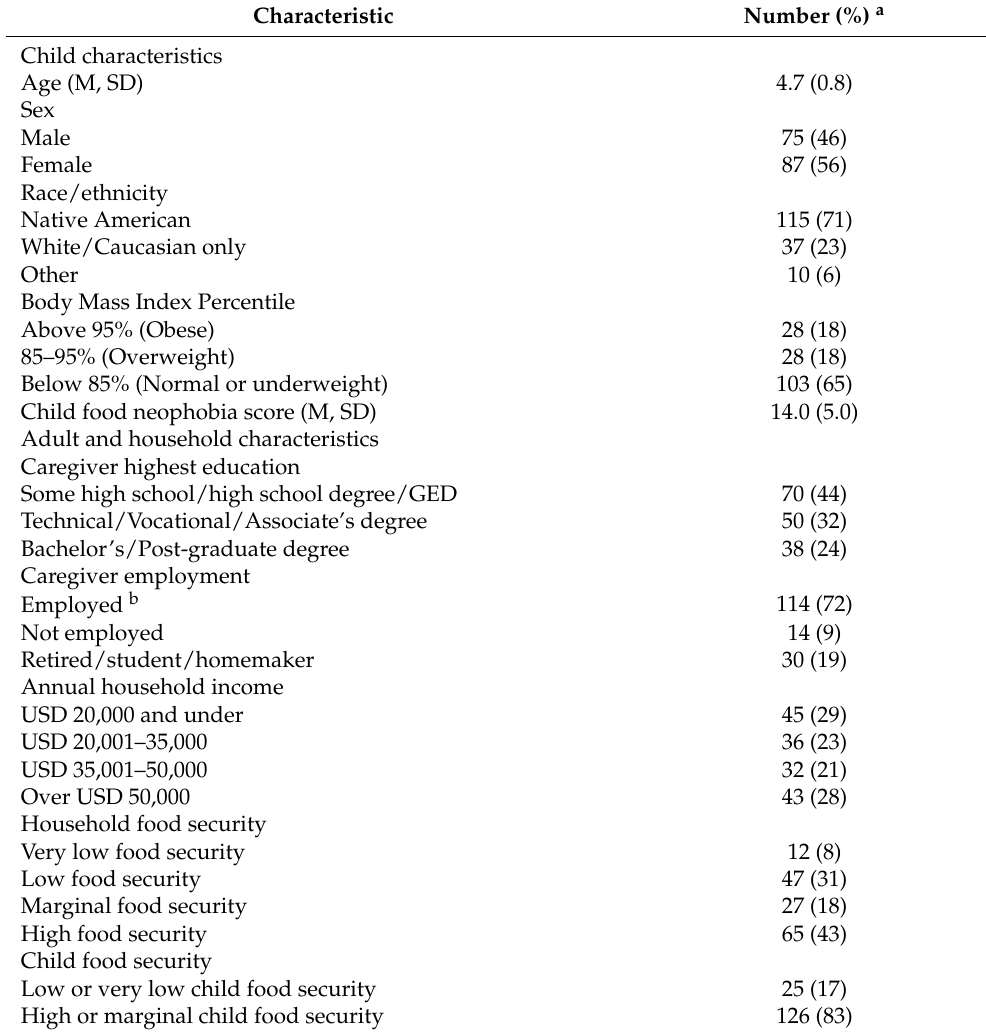
Table 1. Descriptive summary of child, adult, and household characteristics ( n = 164).